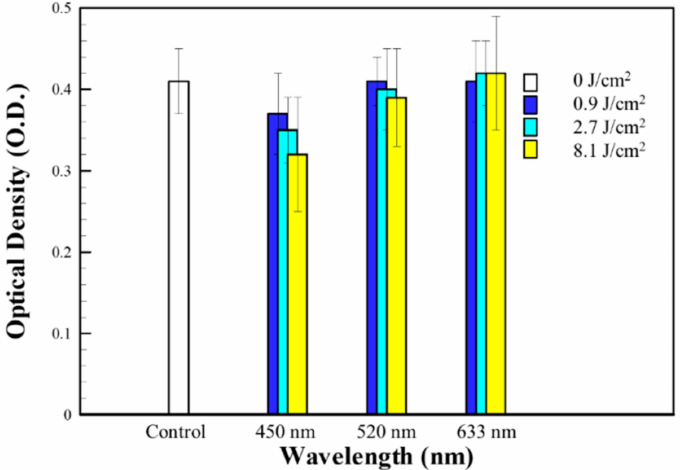
Figure 3. Viability assay of human fibroblast cells in the absence of LLLT (control group) and after LLLT with fluences of 0.9, 2.7, and 8.1 J/cm 2 at 450, 520, and 633 nm,